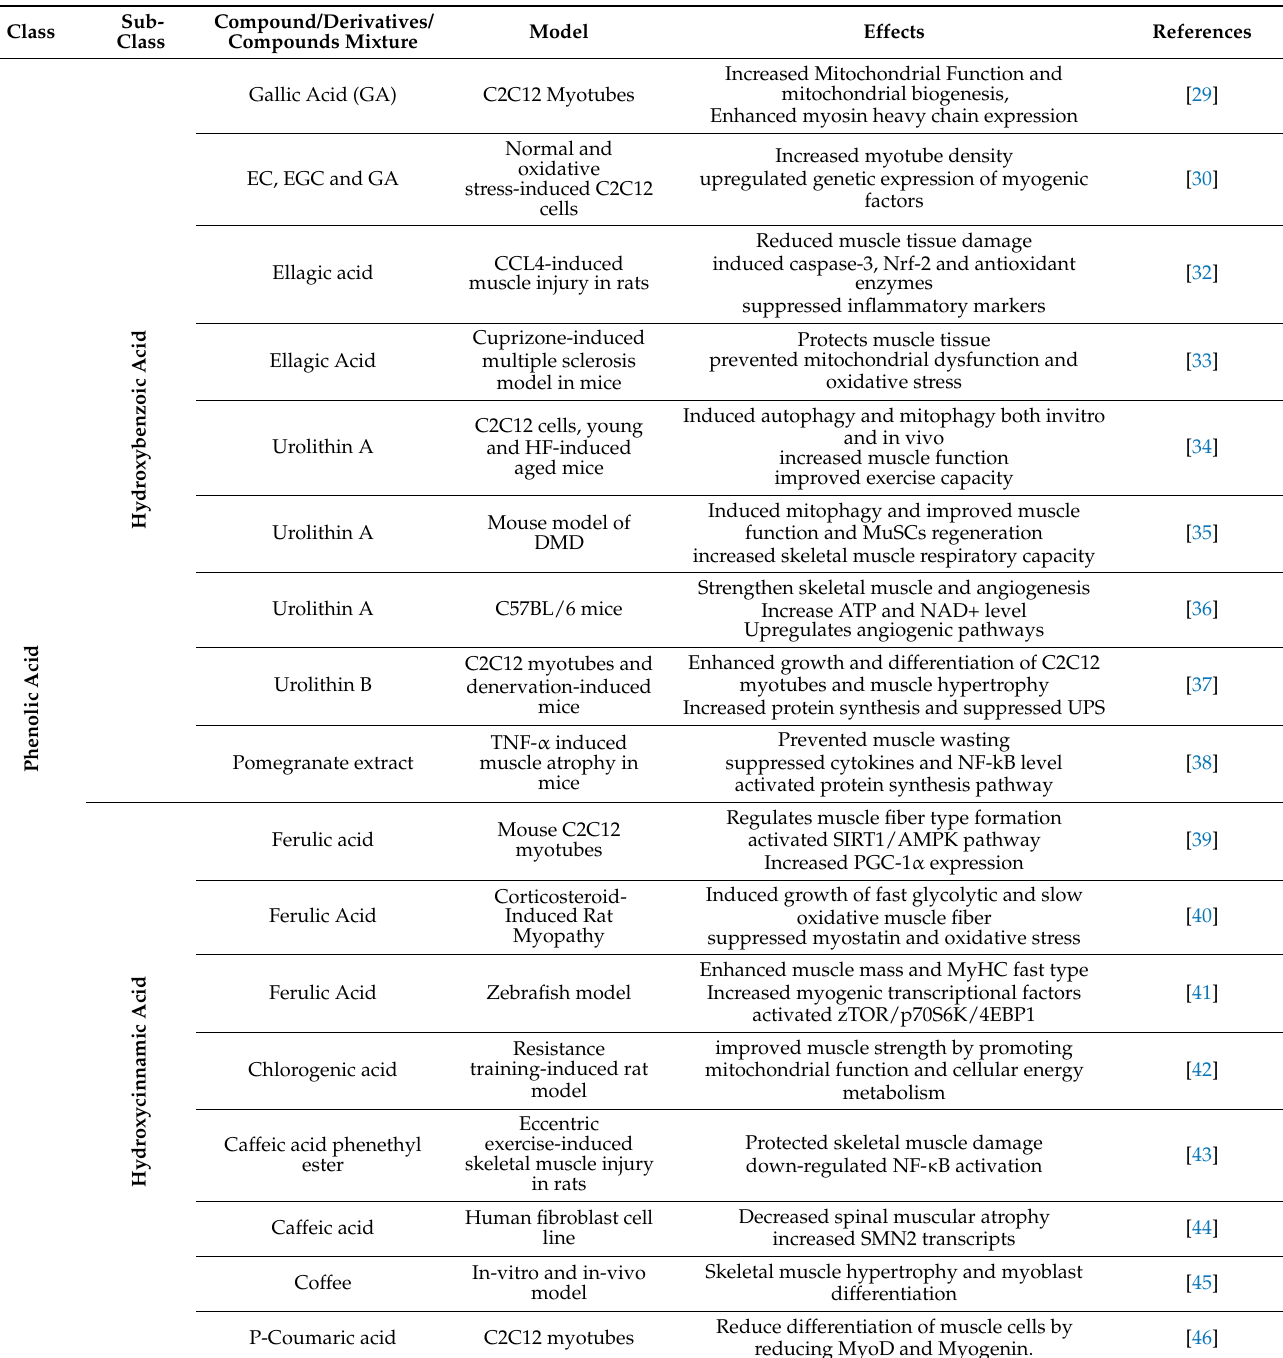
Table 1. Function of phenolic acids and their derivatives in promotion of muscle health and prevention of muscle atrophy. DMD, Duchenne muscle dystrophy; EC, epicatechin; EGC, epigallocatechin; GA, gallic acid; HF: high fat